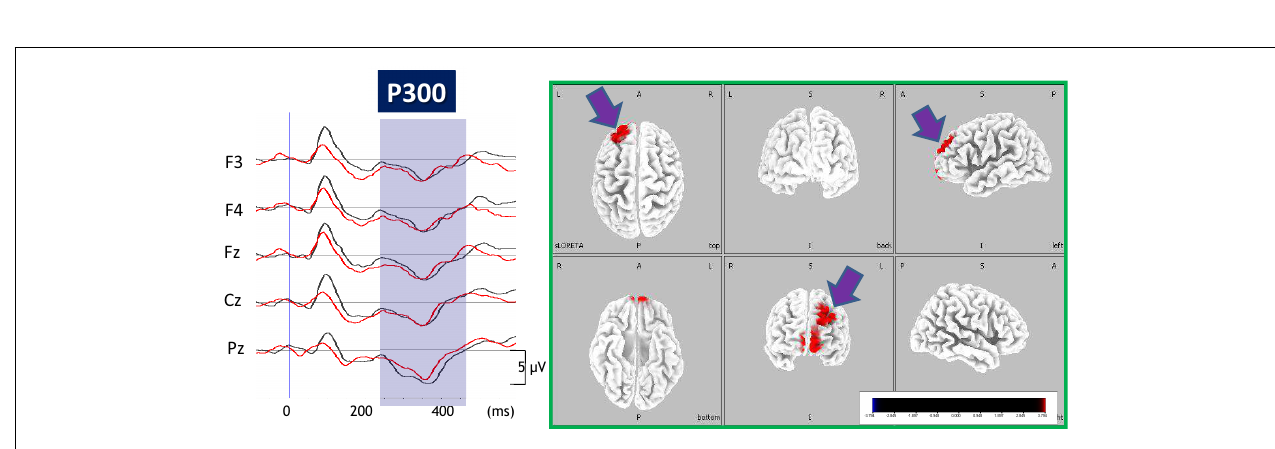
P300 current density, evaluated by the sLORETA method, in the left superior frontal gyrus. Perospirone also improved social cognition, the degree of which was correlated with P300 activity in the frontal brain regions (see